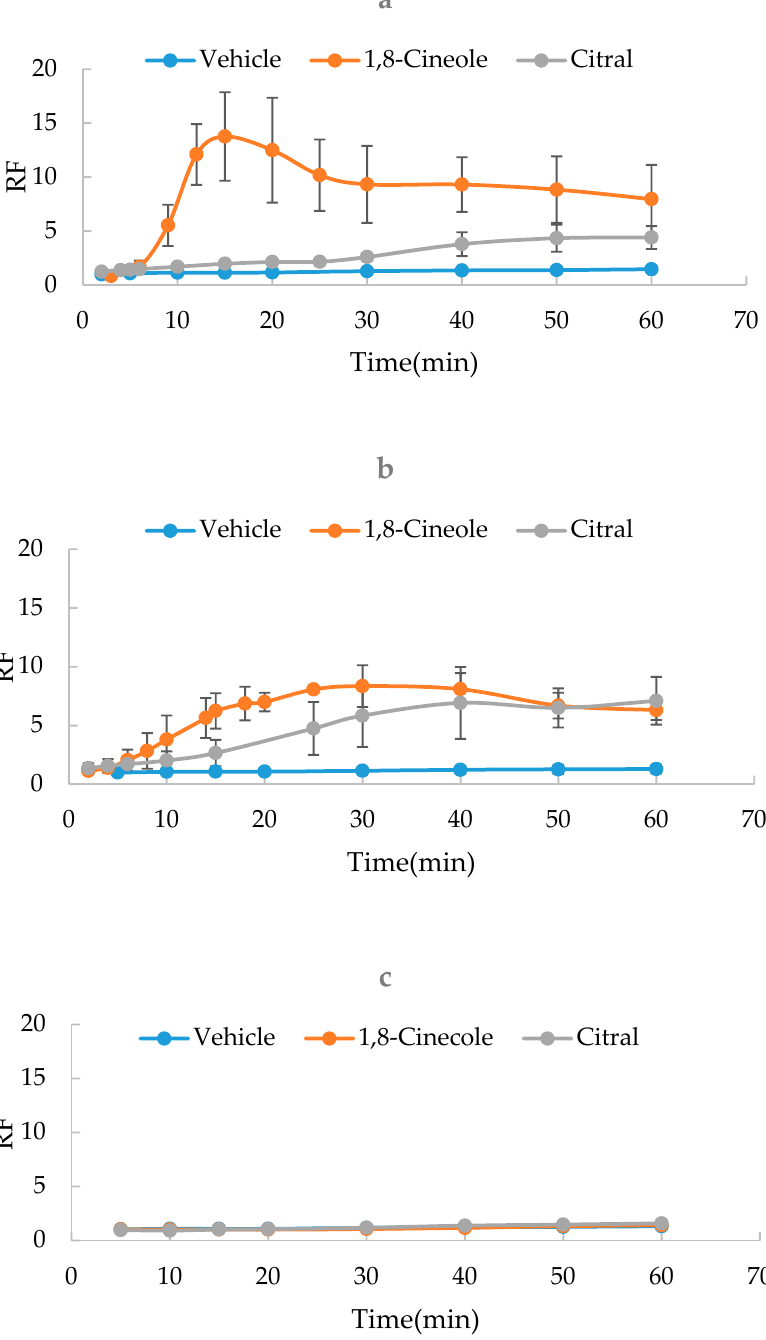
Figure 3. Effect of the terpene concentration on SER kinetics of 1,8-cinecole and citral ( n = 3). ( a ) 5%; ( b ) 3%; ( c ) 1%.